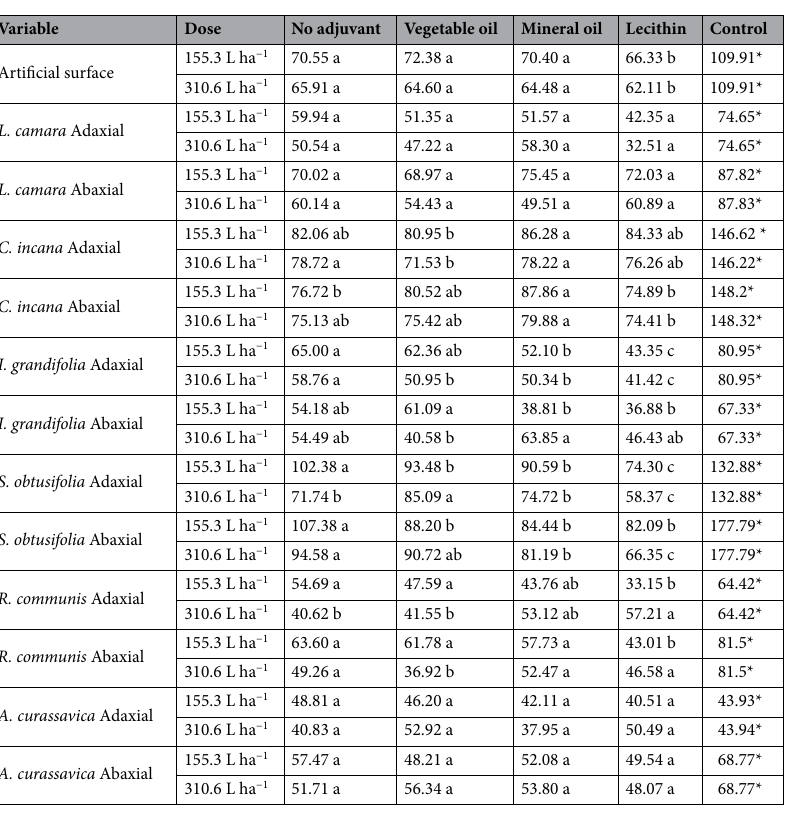
Table 2. Average and standard deviation of the contact angle (°) after drop deposition in surfaces of the leaves of the weeds. Equal letters on the line do not differ from each other by the Tukey’ test (p > 0.05). *The control was different from the treatments by the Tukey’ test (p > 0.05).